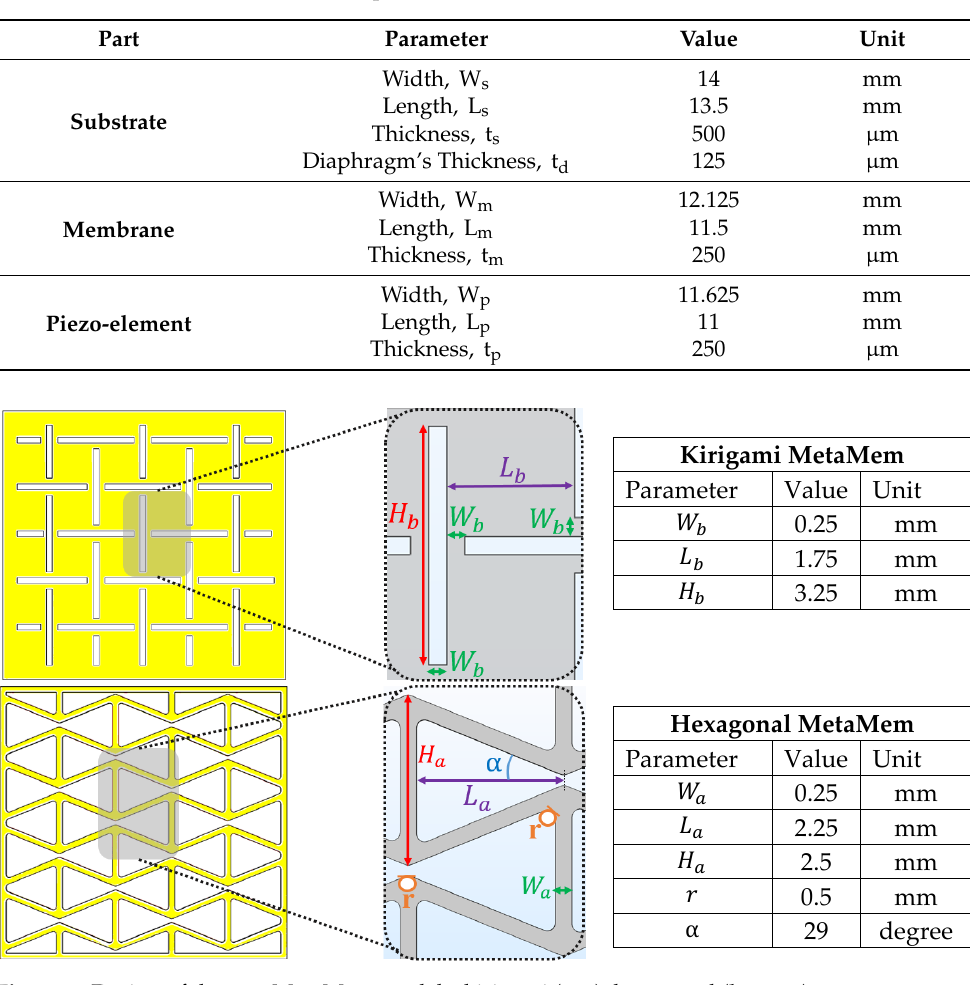
Figure 3. Design of the two MetaMem models; kirigami ( top ), hexagonal ( bottom ).